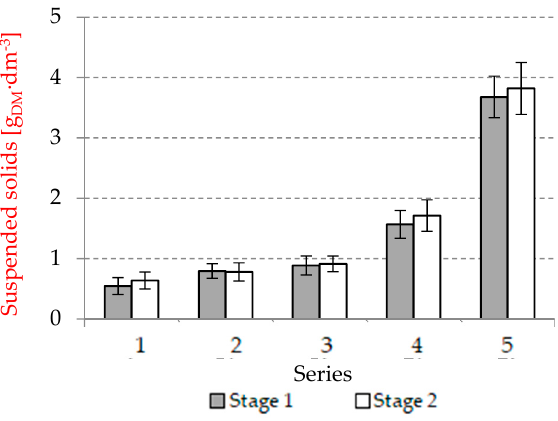
Figure 9. Concentration of suspended solids in the effluent.